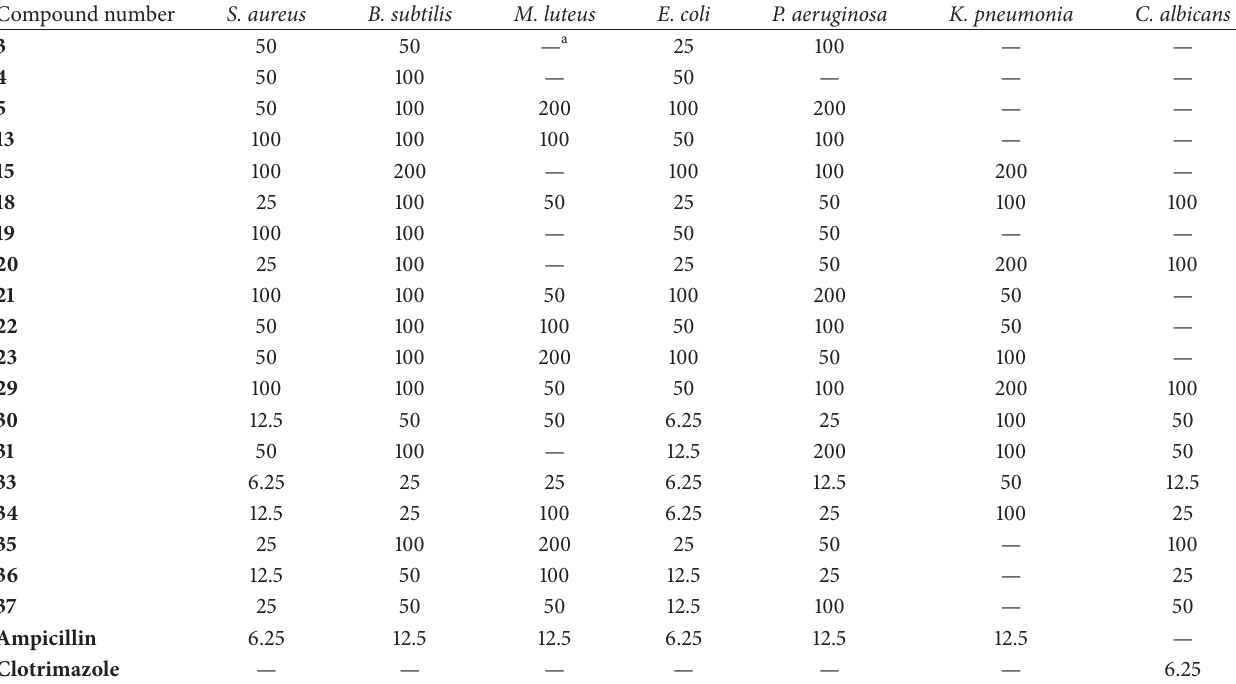
Table 2: Minimal inhibitory concentrations (MIC; 𝜇 g/mL) of the tested